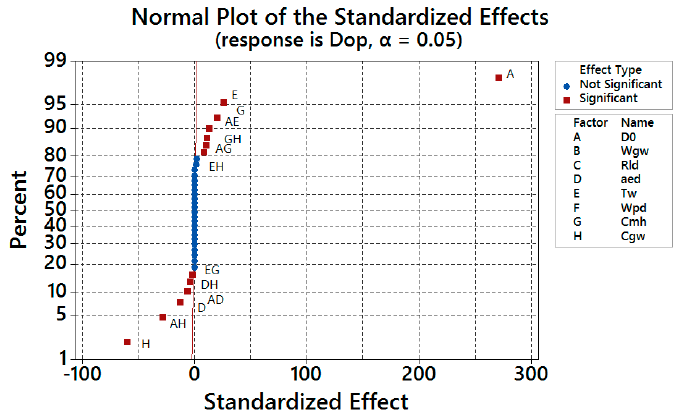
Figure 5. Normal Plot for D e,op .